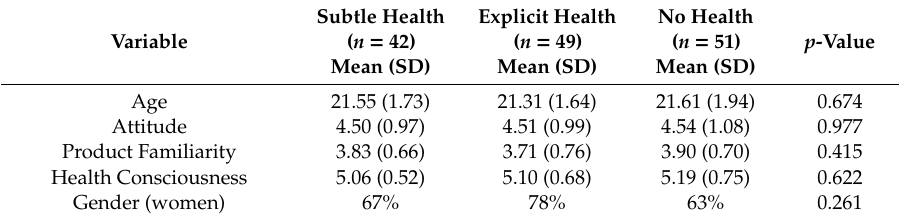
Table 1. Variables measured for the subtle, explicit, and no health information conditions ( n = 142).